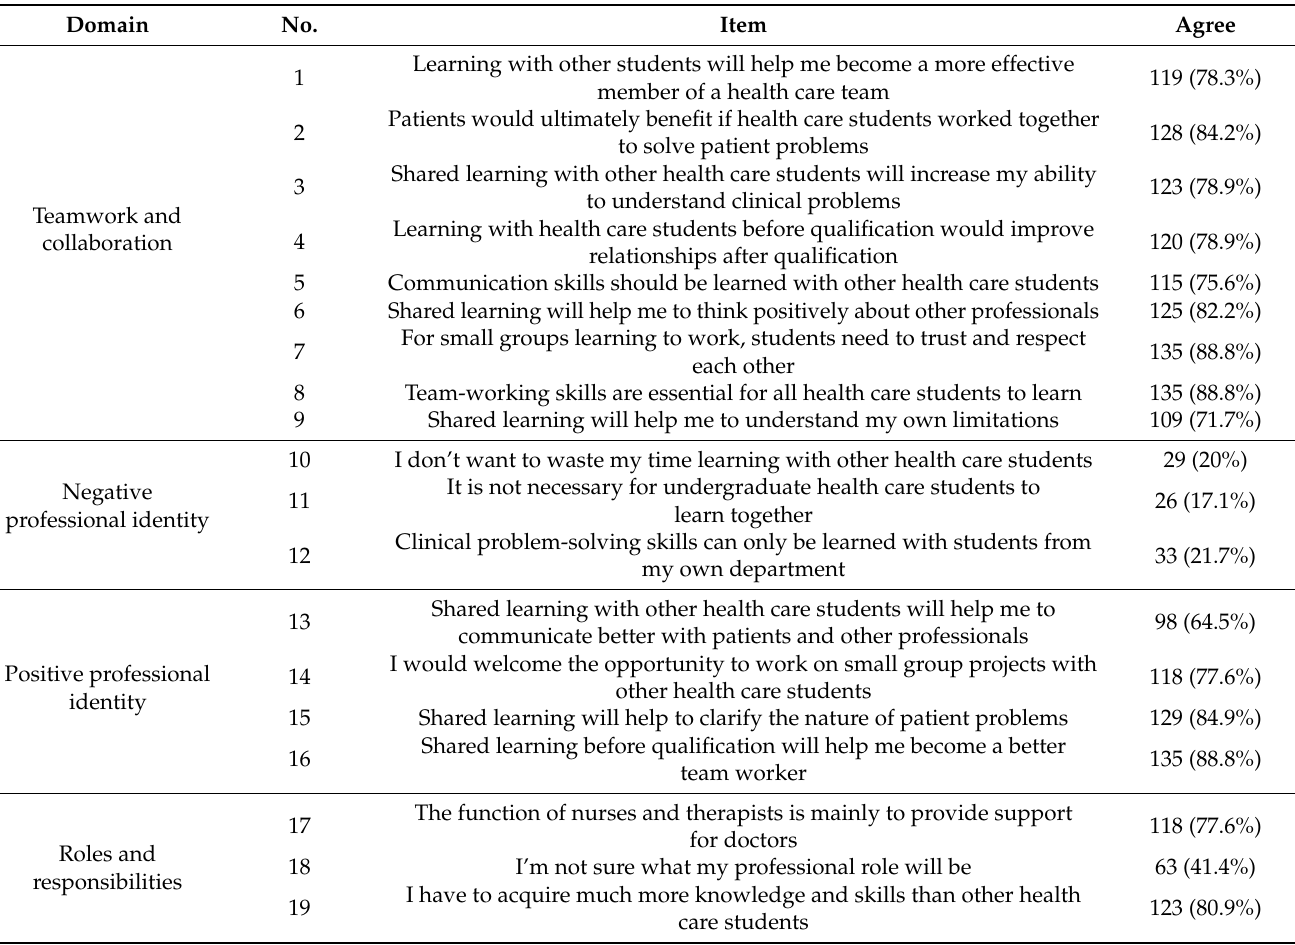
Table 2. Students’ readiness for interprofessional education using the Readiness for Inter-Professional Learning Scale